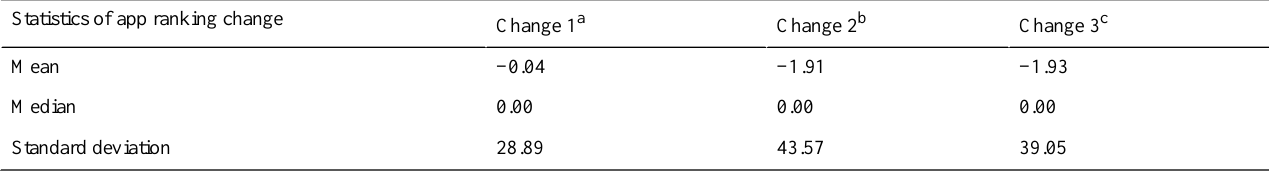
Table 1. Change of app ranking among